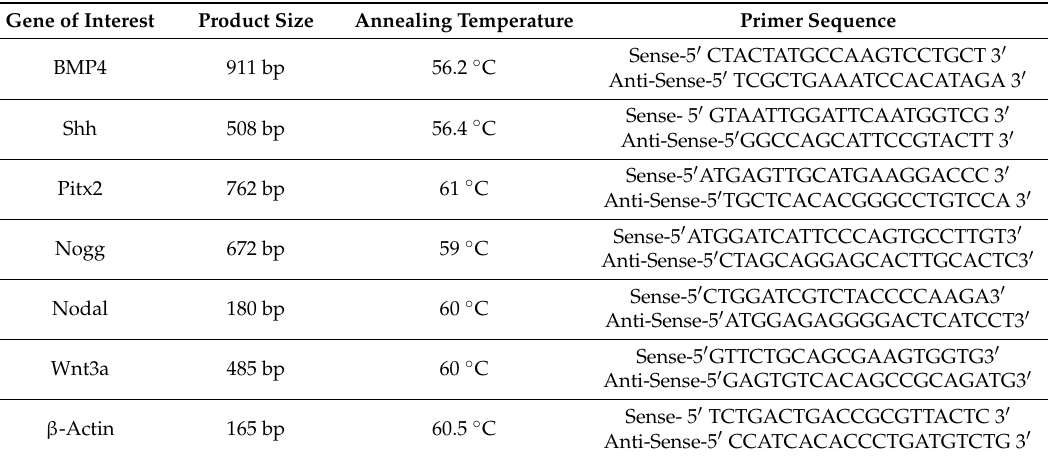
Table 4. Semi-quantitative RT-PCR